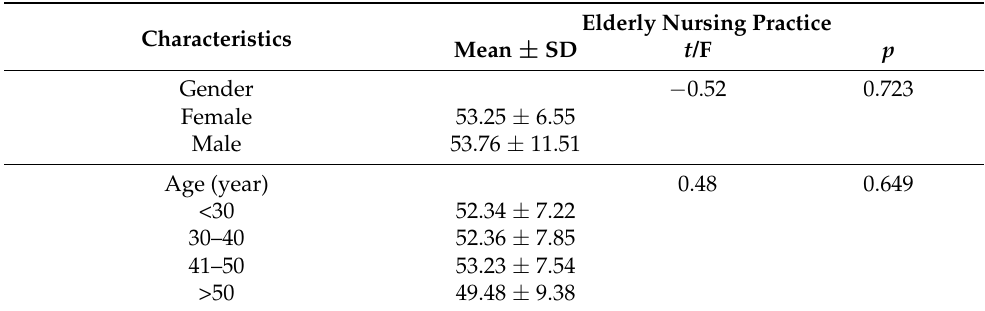
Table 4. Differences in elderly nursing practice according to the general characteristics of study participants ( n =